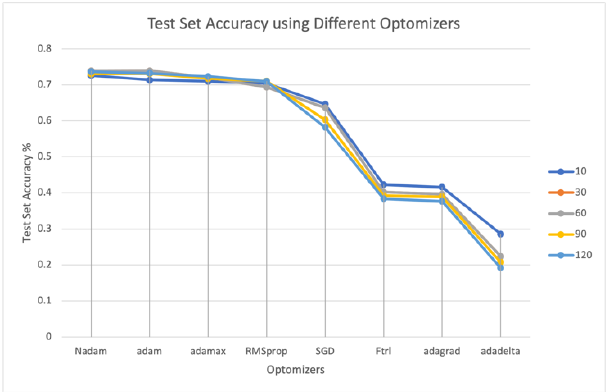
Figure 11. Test set accuracy using different optimizers and batch sizes against GTSRB. The batch size is listed in the legend.